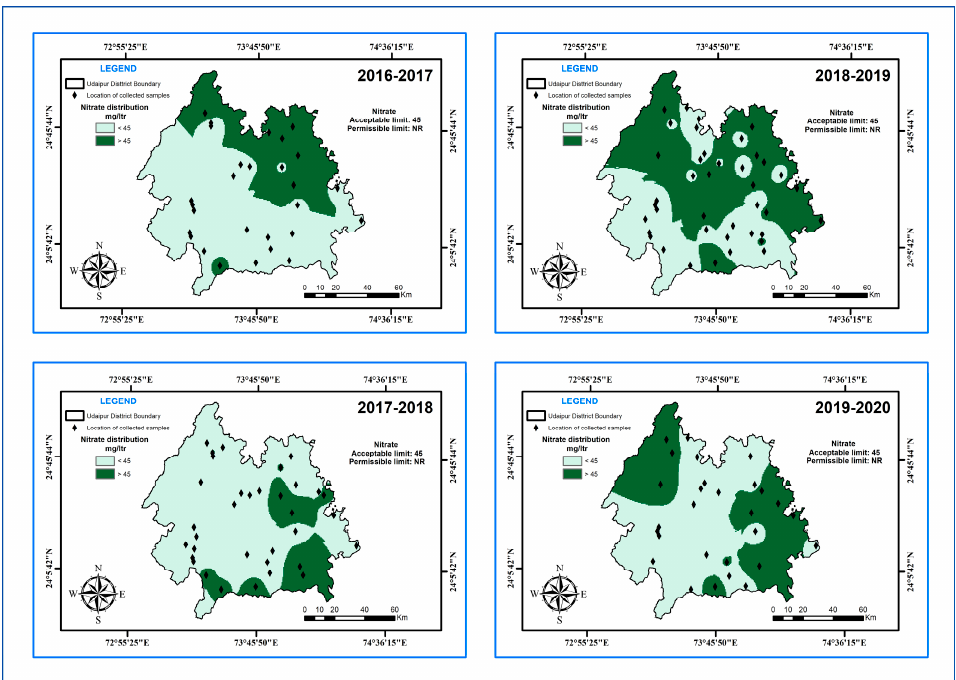
Figure 17. The changing distribution of nitrate from 2016 to 2018 in the study area.